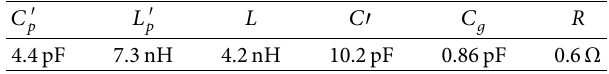
Table 1: Extracted elements of the equivalent